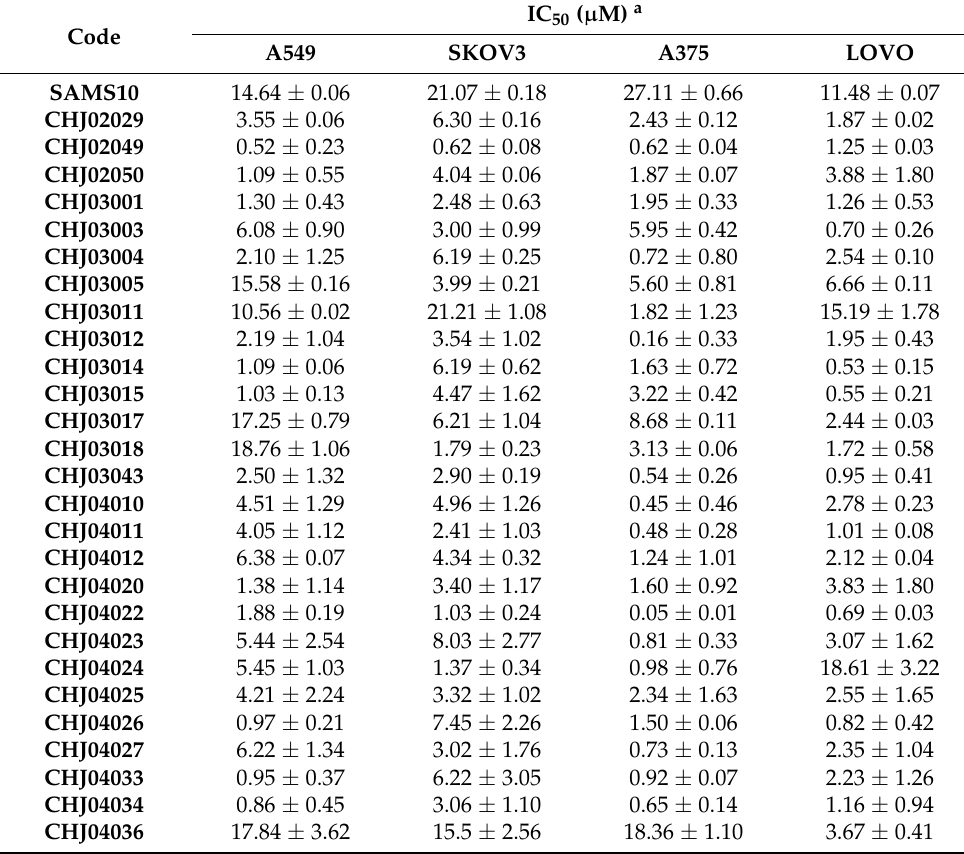
Table 3. In vitro inhibitory activities of CHJ series compounds against the selected cancer cells.